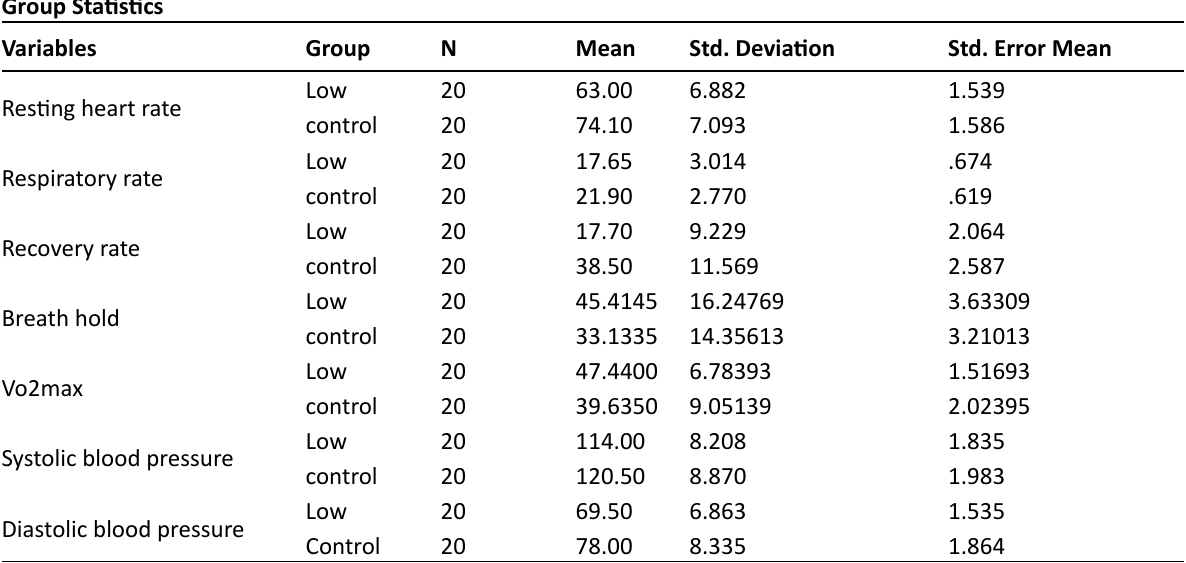
Table 2. The mean value between low-intensity interval training and control group within 8 weeks of follow-up. Group Statistics